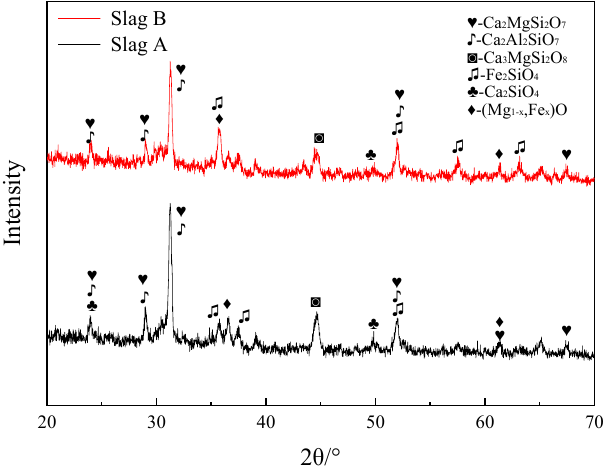
Figure 4. Mineral composition of slag with different w (FeO) at 1400 °C.